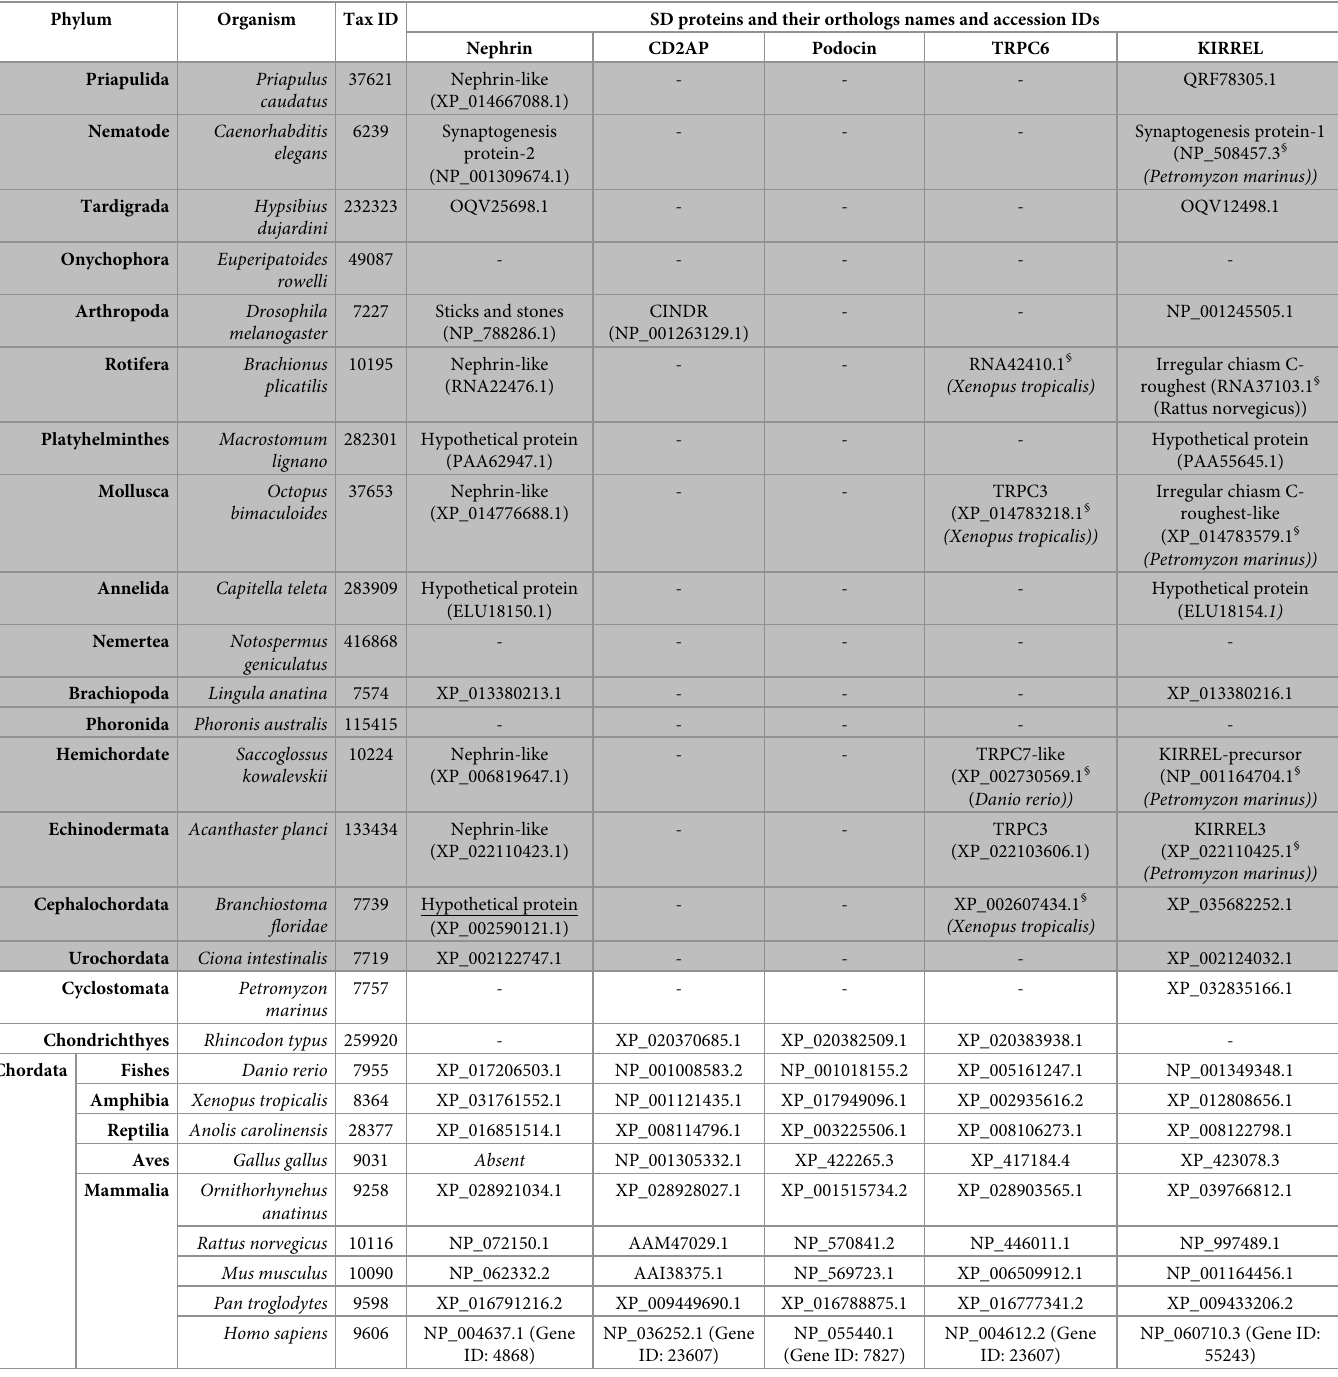
Table 2. Human SD proteins and their orthologs identified by reciprocal best hit method.